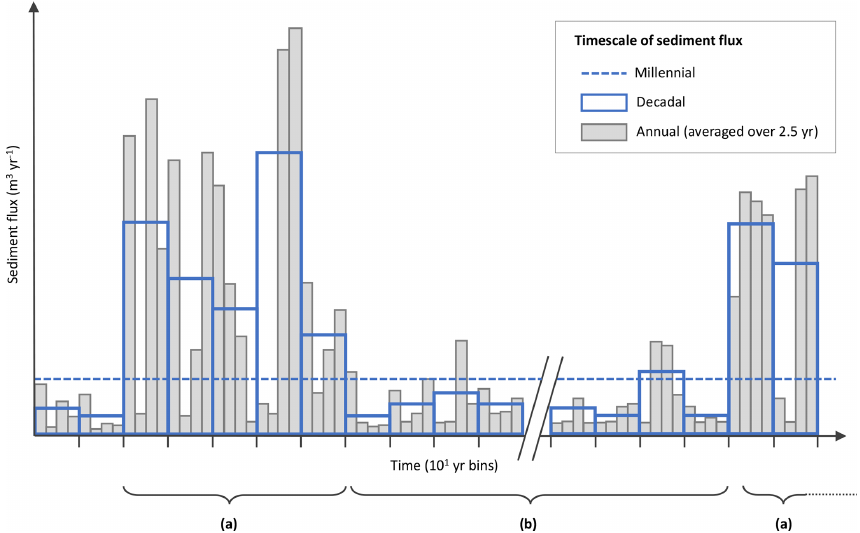
Figure 8. Conceptual representation of the sediment fluxes over different timescales at the outlet of a first-order river catchment. (a) Periods of high hillslope activity due to a landslide sediment pulse, resulting in intermittent hillslope–channel connections and in sediment export to the river network at the annual scale. (b) Periods of low hillslope activity both at the annual and decadal scales, due to poor sediment availability on